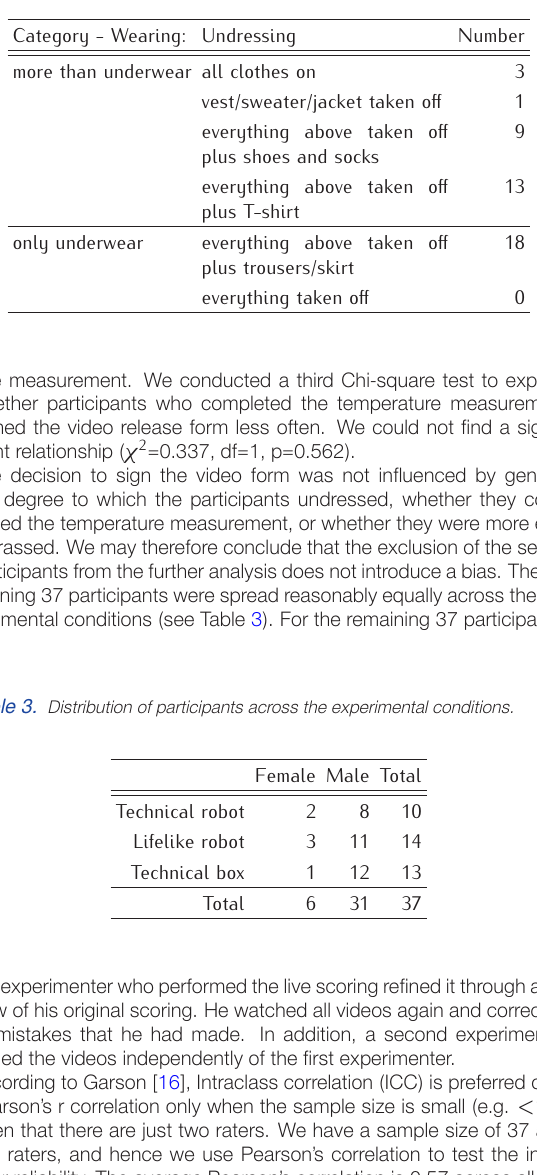
Table 2. Count of undressing behavior.